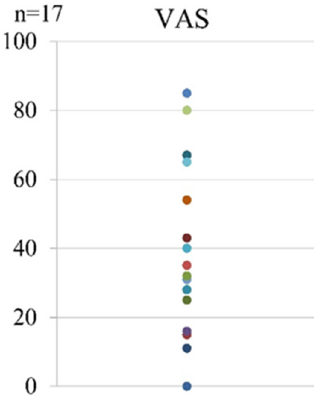
Figure 5. Blood oxygen saturation level before and after exercise using the leg exercise apparatus. Regarding pain after the first LEX exercise, the mean VAS score was 38.5 (range, 0– 85) (Figure 6).